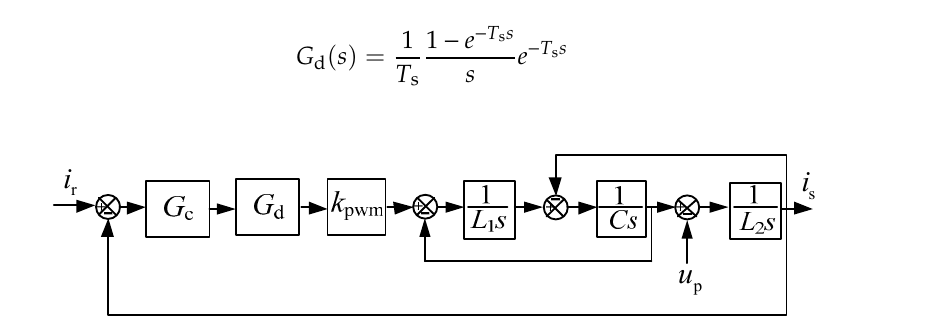
Figure 2. Current control block diagram in s -domain.